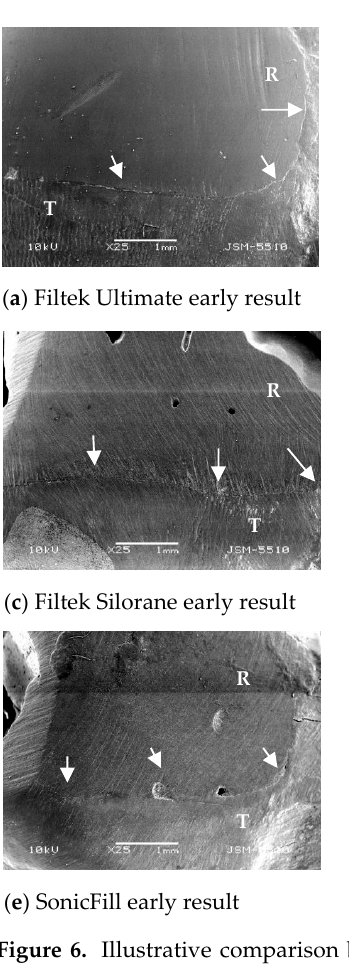
11 of 19 Figure 5. Descriptive comparison between early and late results of microleakage according to mean values. 4. Discussion We expect dental materials to be long lasting in the oral cavity. Composite restora- tions must withstand complex conditions that vary, including depending on the pa- tient—dietary factors, chugging habits, saliva and enzymatic activity, thermal fluctua- tion, and oral hygiene. To predict and mimic the influence of oral conditions, the resto- rations of different materials in the present study were prone to thermal changes and ageing for ten months in a wet environment. Thermal stress attacks the marginal integ-